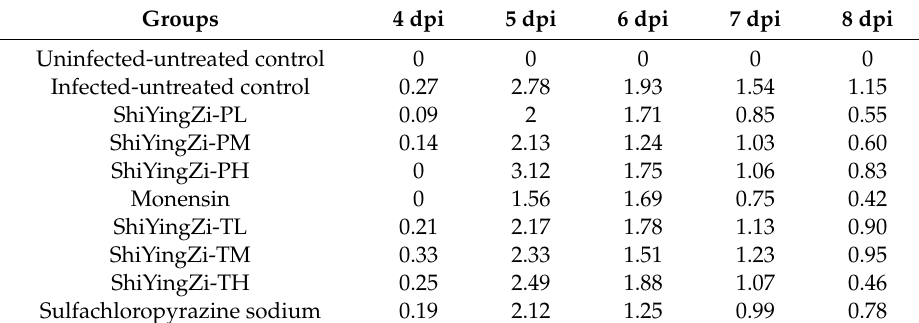
Table 3. The number of oocysts per gram of feces ( × 10 6